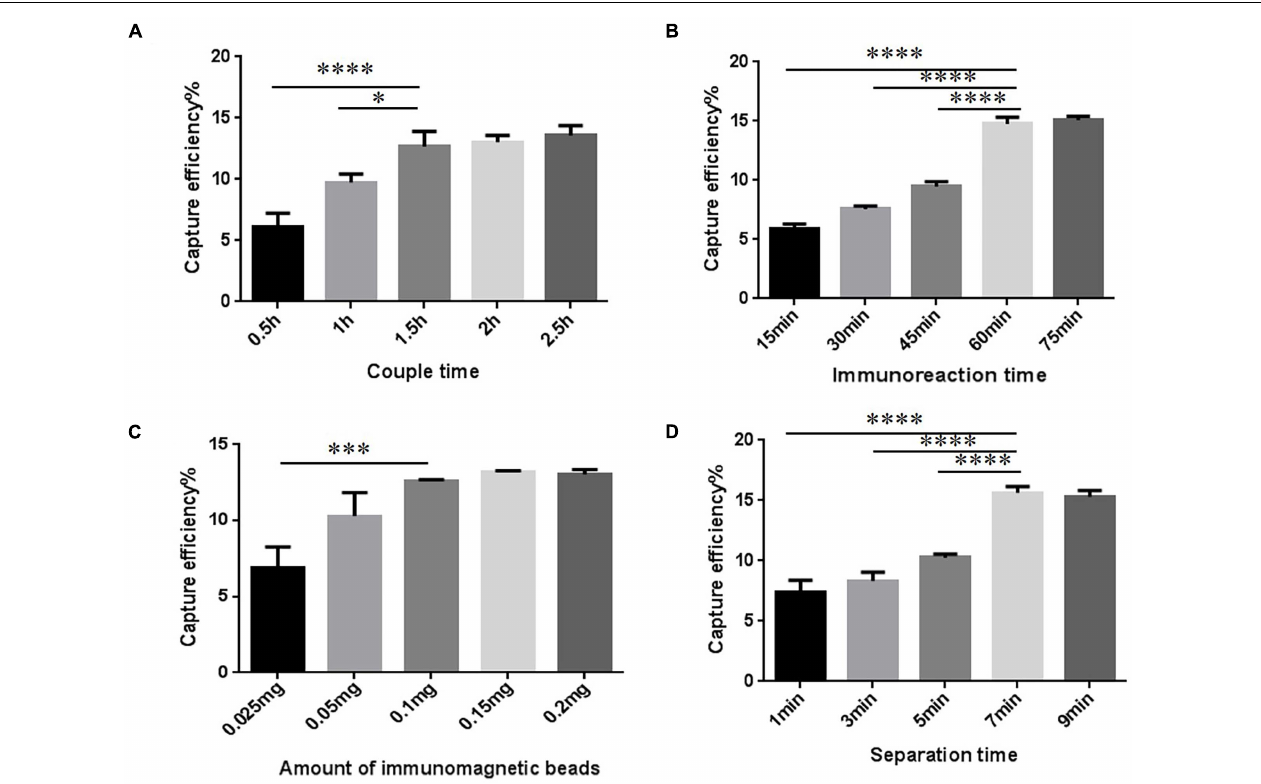
FIGURE 2 | Optimization of traditional immunomagnetic enrichment (T-IME) conditions. (A) Optimization of couple time. (B) Optimization of immunoreaction time. (C) Optimization of the amount of immunomagnetic beads. (D) Optimization of separation time. Optimization of the conditions of the T-IME method by setting a series of gradients. Capture efficiency (CE) under different conditions are calculated, and the best enrichment conditions are selected based on the principle of high CE, and time and cost saving. ∗ P < 0.05, ∗∗∗ P < 0.001, ∗∗∗∗ P < 0.0001.